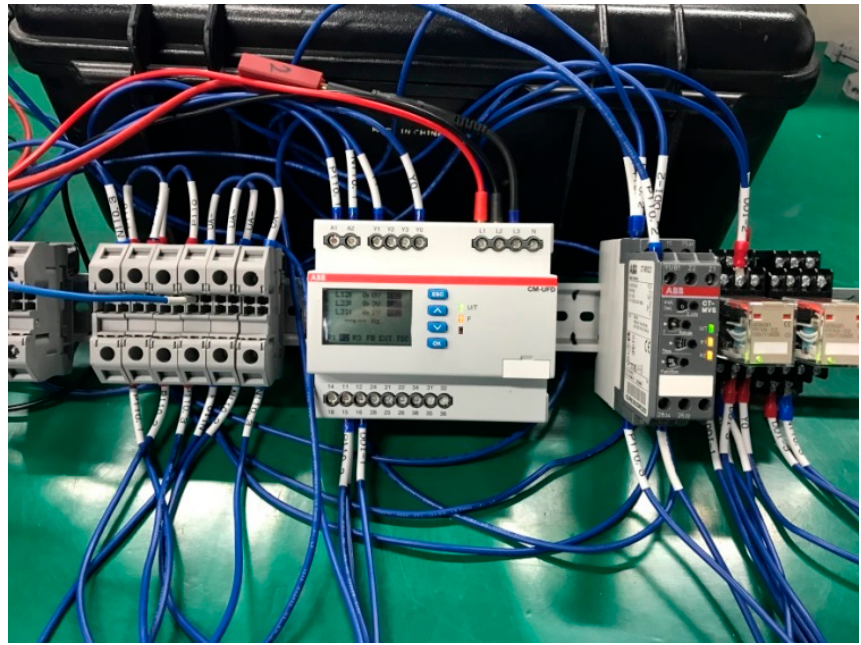
Figure 23. Assembling a test jig to test the relay.